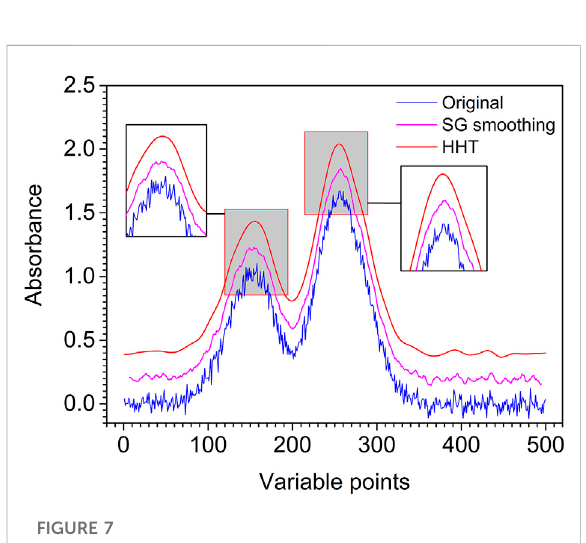
FIGURE 7 Original (blue line), SG smoothing (pink line), and HHT denoising (red line) arti fi cially chemical noised